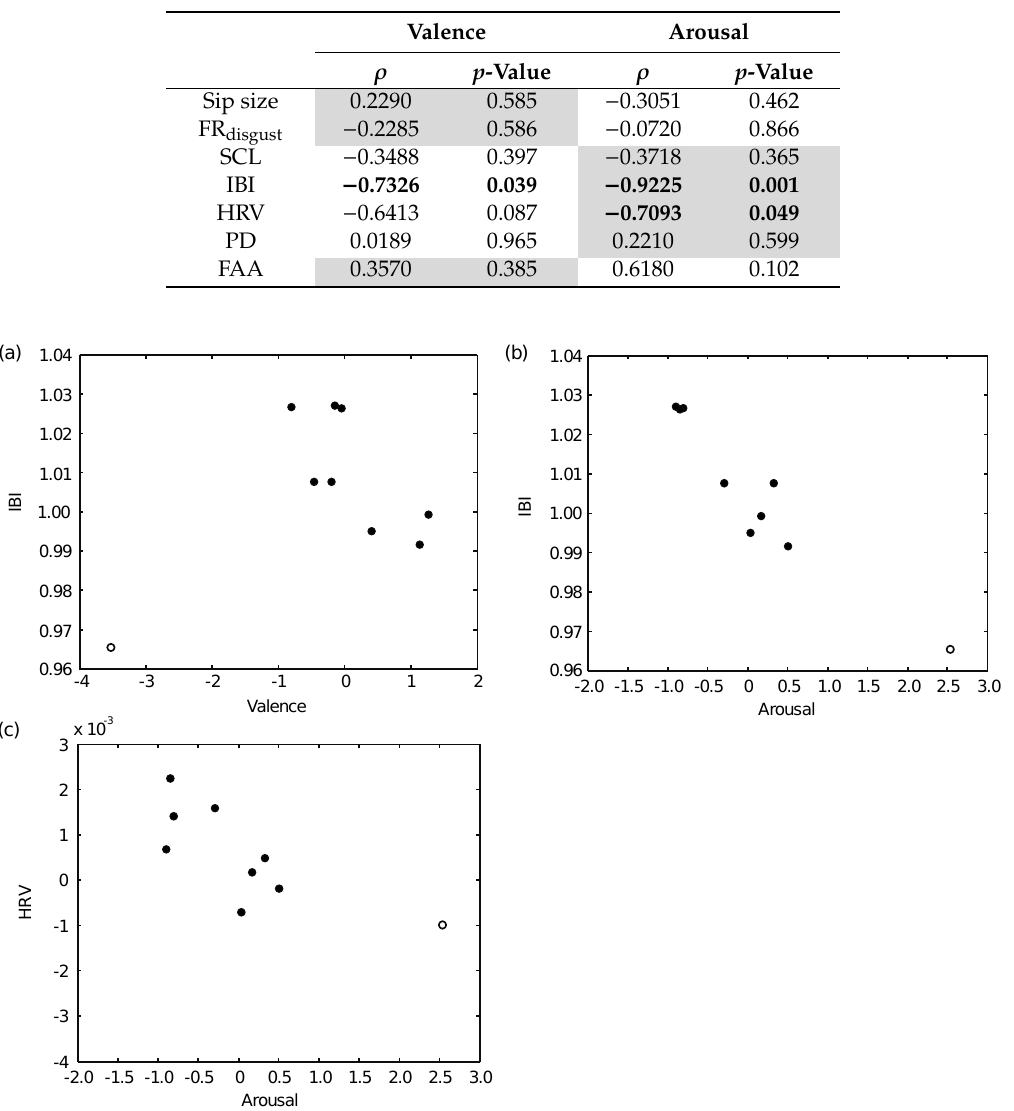
Table 4. The summarized correlation analysis between explicit ratings (valence and arousal) and behavioral (sip size and FR disgust ) and physiological measures (SCL, IBI, HRV, PD, and FAA). The cells highlighted in light gray represent the correlations we hypothesized based on the physiological literature. The bold data represent significant correlations ( p < 0.05).